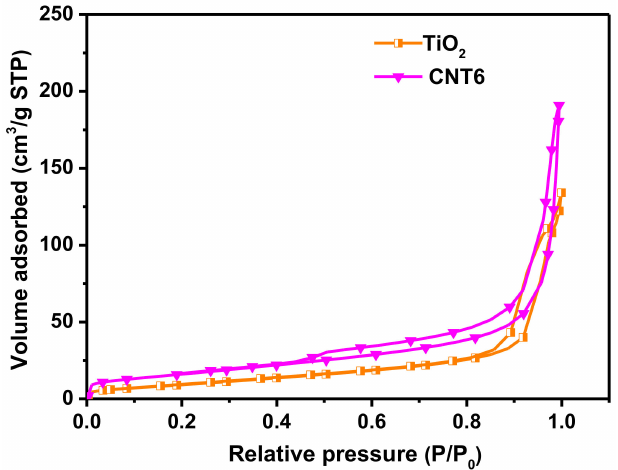
Figure 5. Nitrogen adsorption–desorption